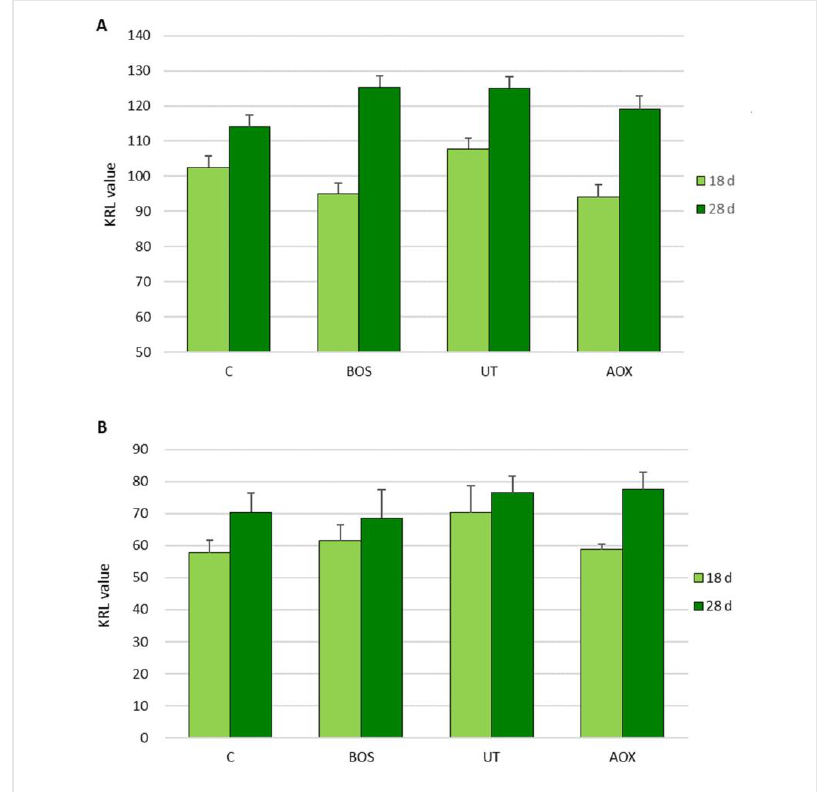
Figure 2. The KRL value of piglets’ whole blood ( A ) and red blood cells ( B ), covaried by KRL val- ues at the beginning of the trial, in relation to dietary treatments and sampling time. Data are re- ported as mean ± SEM; n = 16. C, control group; BOS, diet supplemented with B. serrata extract; UT, diet supplemented with U. tomentosa and T . parthenium extracts; AOX, diet supplemented with antioxidant plant extract mixture. For whole blood: Treatment p = 0.123; Time p = 0.543; Time × Treatment interaction, p = 0.002. For red blood cells: Treatment p = 0.003; Time p = 0.795; Time × Treatment interaction p = 0.014.